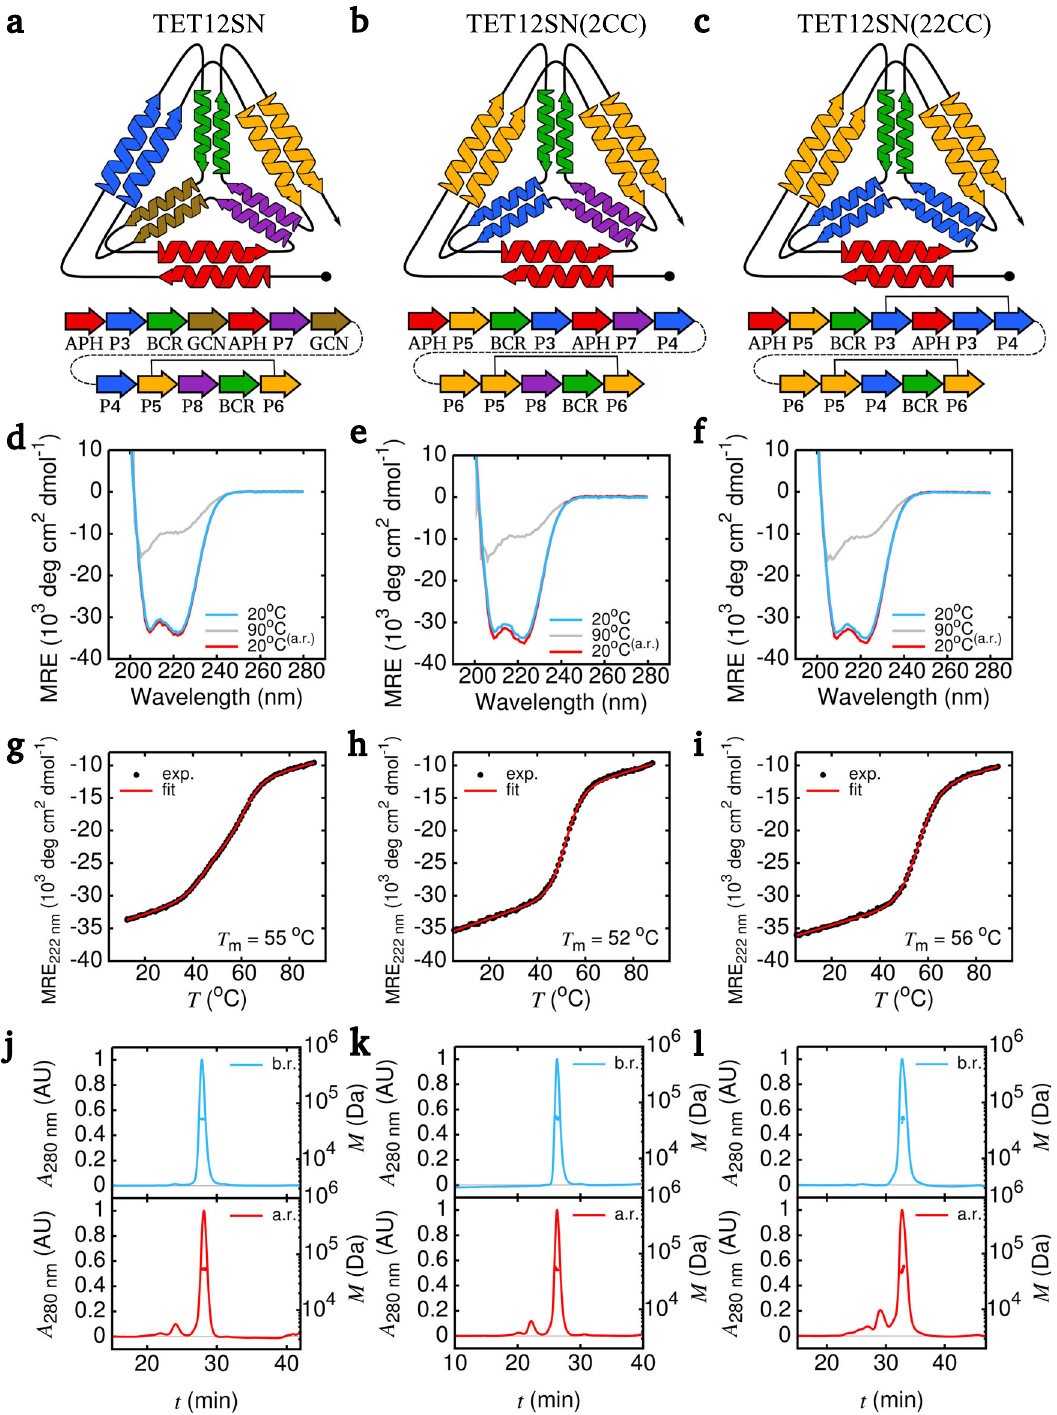
Fig. 3 Biophysical characterisation of designed tetrahedral protein cages with one or two CC building modules repeated in the amino acid sequence. Schematic illustration of designed CCPO cages. TET12SN contains only unique CC modules ( a ), TET12SN(2CC) contains two copies of the coiled-coil pair P5SN:P6SN ( b ), while two copies of both P3SN:P4SN and P5SN:P6SN are present in TET12SN(22CC) ( c ). In all cases, peptide modules are connected by a GSGPG linker. For reoccurring CC building blocks, the solid black line is intended to help discern on-target peptide pairings. d – f Circular dichroism (CD) spectra at 20 °C (blue), 90 °C (grey) and 20 °C after denaturation and rapid refolding (red). CD signal was converted to mean residue ellipticity (MRE) to facilitate comparison. g – i Temperature denaturation was monitored with CD at 222 nm. Melting temperatures ( T m ) were determined using a two-state model. j – l Monodispersity of protein cage solution samples was analysed by SEC coupled to MALS before (blue) and after (red) temperature denaturation. Elution pro fi les were monitored by UV absorbance at 280 nm ( A 280 nm ). Molecular weight ( M ) was determined from light scattering. Source data are provided as a Source Data fi